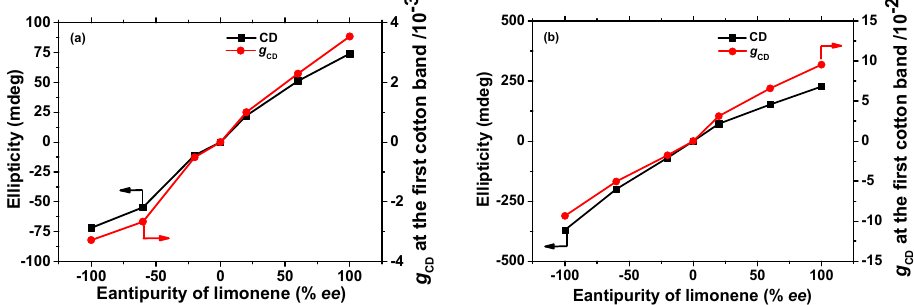
Figure 5. Plots of maximum CD and g CD values of the PAzoMA 1 in the solution ( a ) and films ( b ) with different enantiopurity of limonene. These data were taken from Figure S8. The solution and films were both heated to 70 °C and measured after being cooled down to 60 °C.